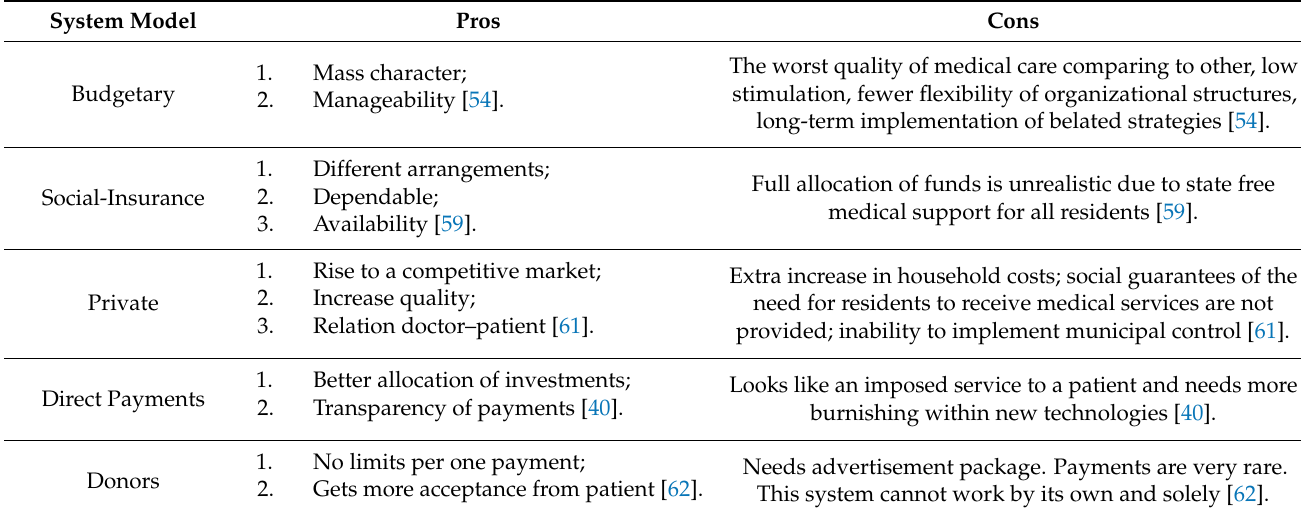
Table 5. Comparative characteristics of healthcare financing models in